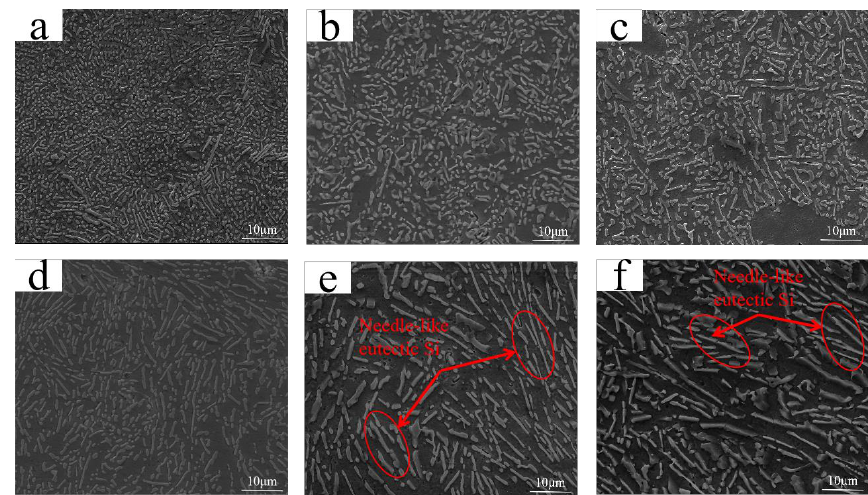
Figure 4. FESEM images showing the morphology and distribution of eutectic Si in the annealed Al-14.5Si alloys under a super-gravity field: ( a ) A-0; ( b ) A-0.25; ( c ) A-0.5; ( d ) A-1; ( e ) A-2; ( f ) A-4. Table 1. The mechanical properties of the annealed Al-14.5Si alloys solidified under a 3000 g gravity field after annealing.